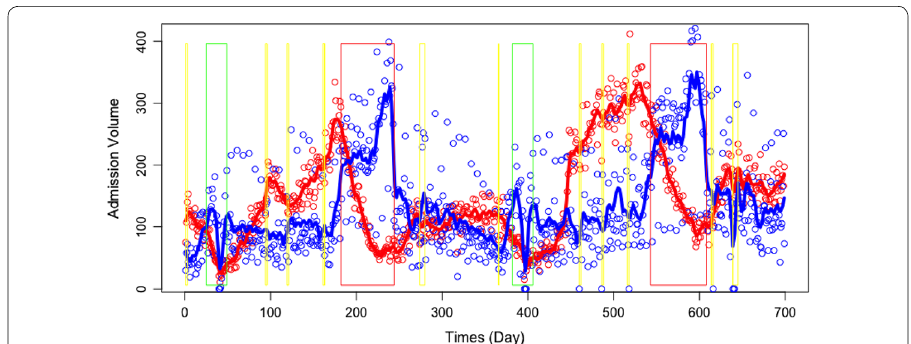
Fig. 2 Comparison of outpatient admissions between the endocrinology and infectious disease departments during 2013–2014. The blue and red lines are de‑seasonalized admissions to the endocrinology and infectious disease departments. Green and red boxes represent winter and summer school vacations, and yellow boxes are public